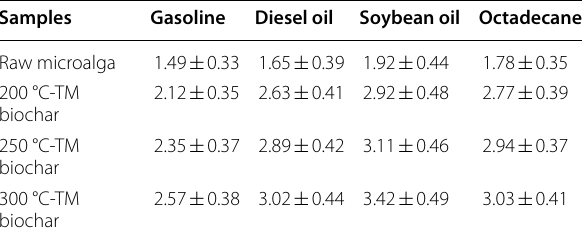
Table 1 Oil adsorption capacities (g g ‑1 ) of raw microalga and